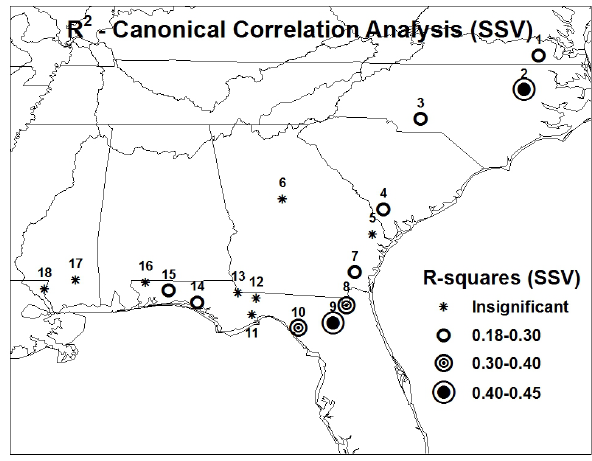
Figure 6: Modified R 2 (based on equation (3)) of CCA model predicted TN loadings obtained Fig. 6. Modified R 2 (based on Eq. 3) of CCA model predicted TN using PC’s of forecasted precipitation under SSV. loadings obtained using PCs of forecasted precipitation under SSV.